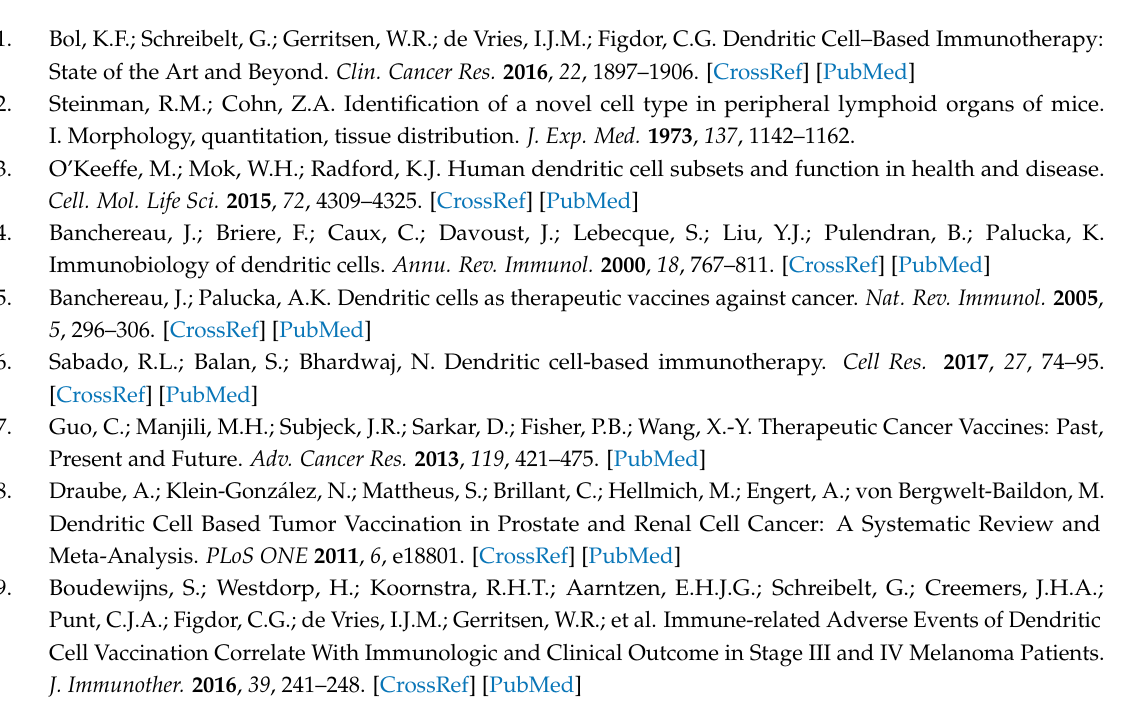
Table S1: List of published studies with DC vaccines in gynecological and breast cancers, from 2000 to date. Author Contributions: Conceptualization, L.E.K.; Resources, S.M.L,M.G., andC.C.; Writing-OriginalDraftPreparation, S.M.L.; Writing-Review & Editing, S.M.L, M.G., C.C., L.E.K.; Visualization, S.M.L., L.E.K.; Supervision,